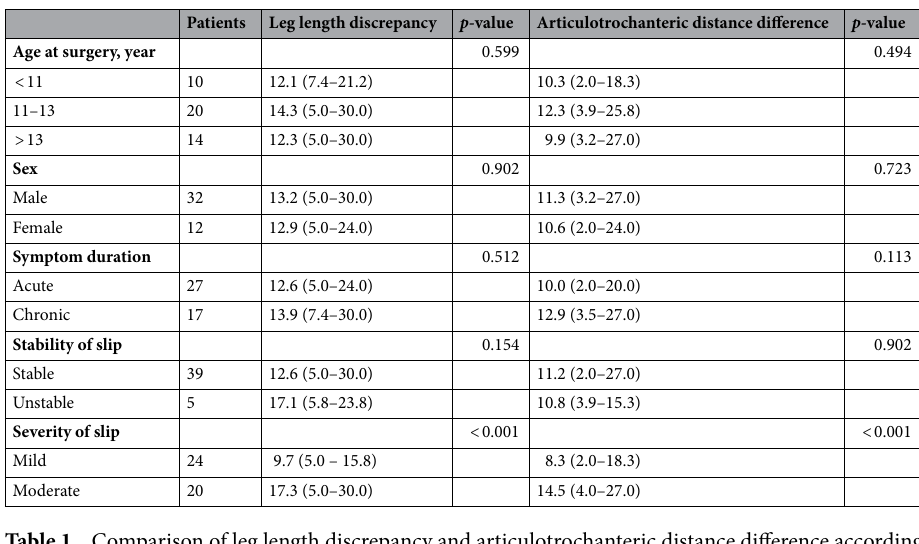
Table 1. Comparison of leg length discrepancy and articulotrochanteric distance difference according to clinical and radiological variables. Values are expressed as the means (range) unless otherwise indicated.